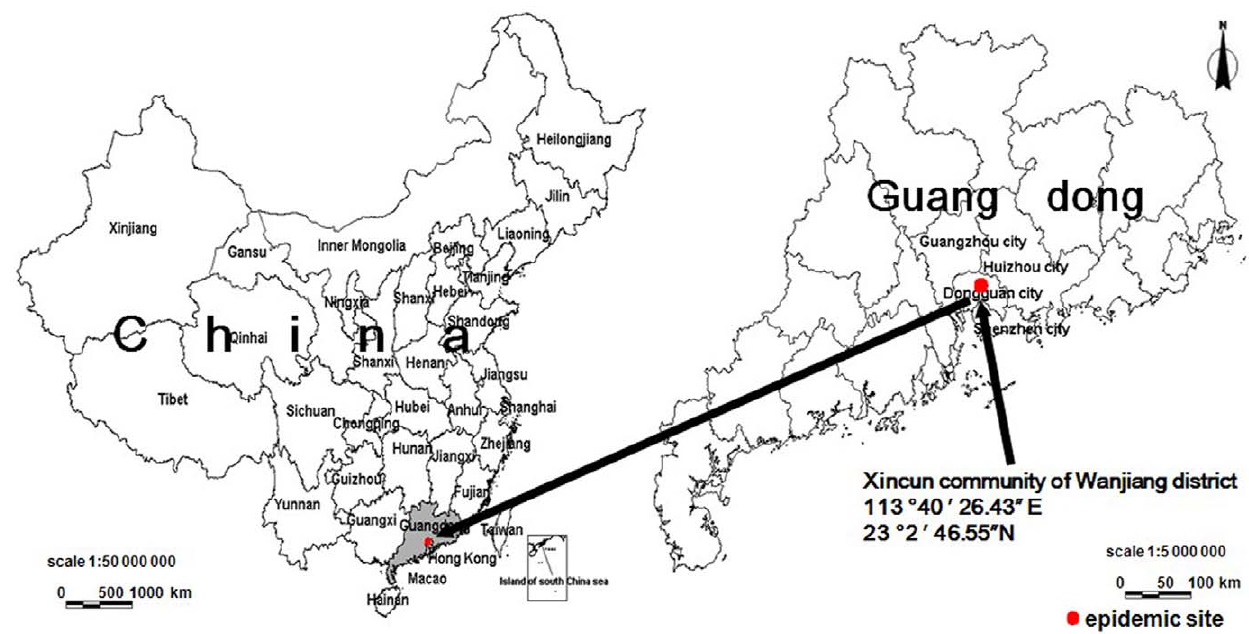
Figure 1. Location of the epidemic site of the CHIK fever outbreak at Xincun community.